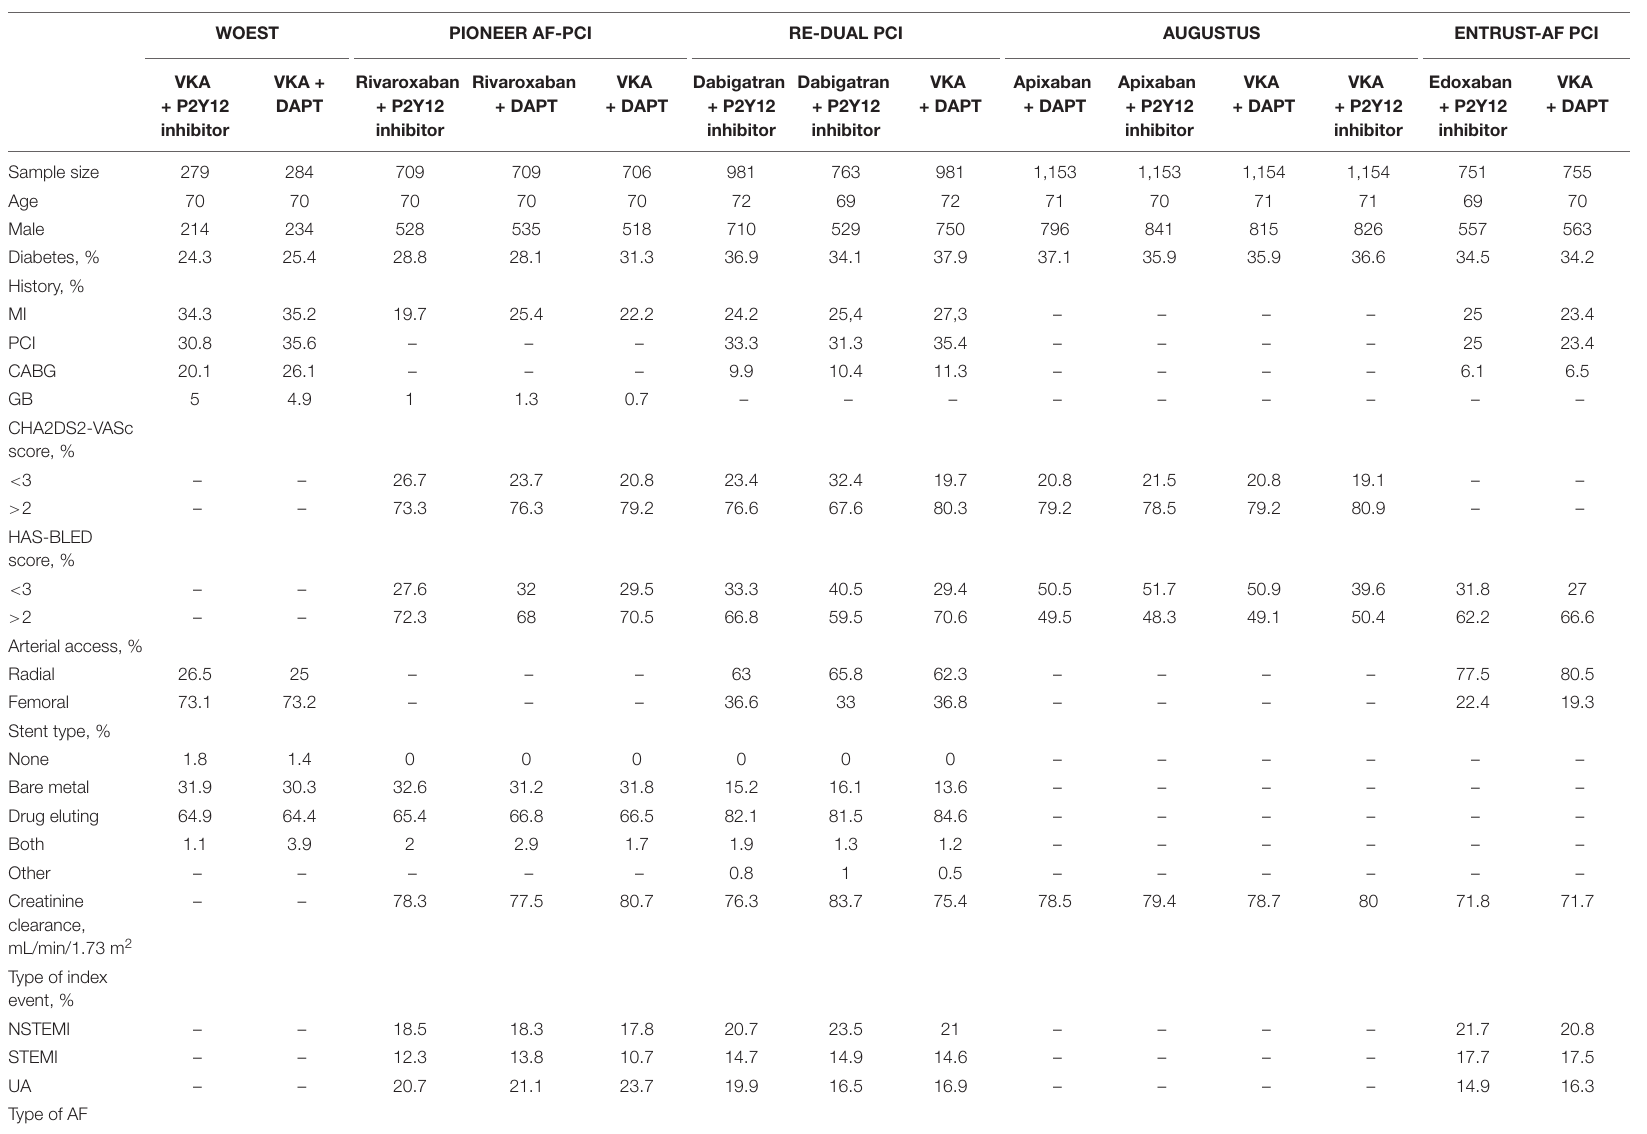
TABLE 2 | Patient